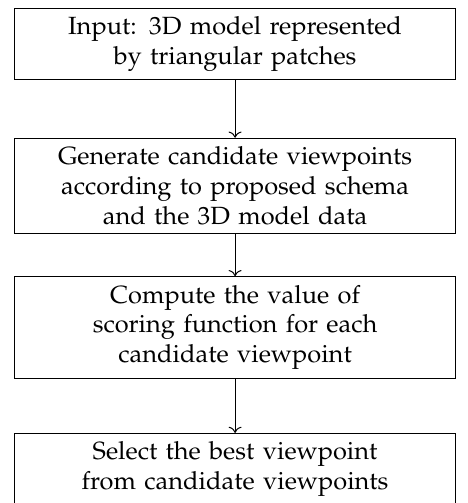
Figure 18. The overview of viewpoint selection scheme.